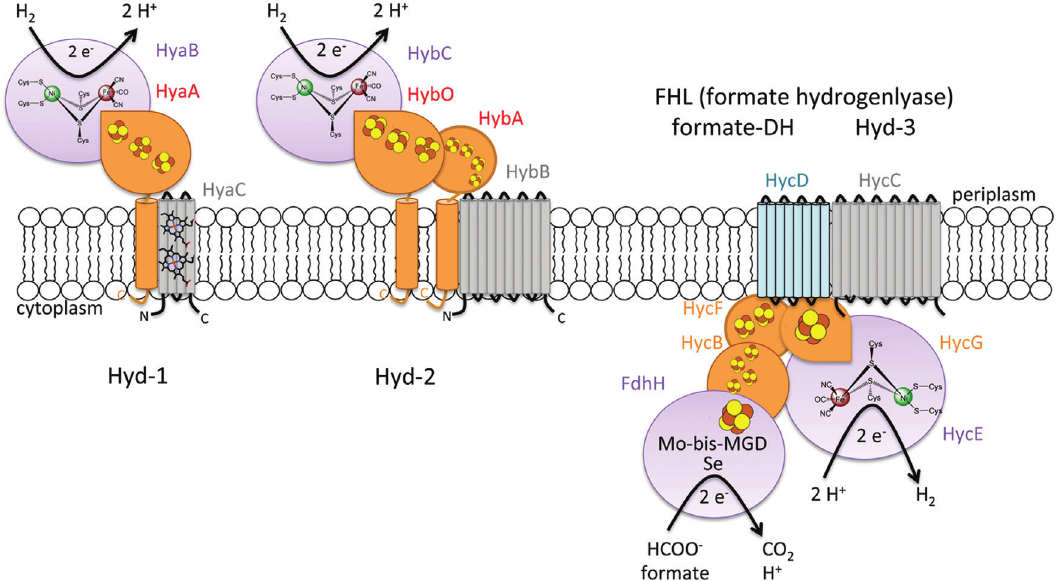
Figure 2 Arrangement of [NiFe]-hydrogenases in the E. coli cytoplasmic membrane [modified from ref. (18)]. The H -oxidizing enzymes (Hyd-1 and Hyd-2) have their active sites located within the periplasm, while Hyd-3 is part of the formate hydro- 2 genlyase (FHL) complex that is oriented toward the cytoplasm and catalyzes H production. The large subunit harbors a catalytic [NiFe]-site 2 and is shown in purple. The formate dehydrogenase H (Fdh-H) subunit contains a selenocysteine (Se) and a molybdopterin guanine dinu- cleotide (Mo-bis-MGD) in its active site. The respective small subunits and further electron-transferring subunits are shown in orange, and membrane subunits are shown in gray or blue. The Fe-S clusters are shown as brown (Fe) and yellow (S) circles, while heme b molecules are shown as stick